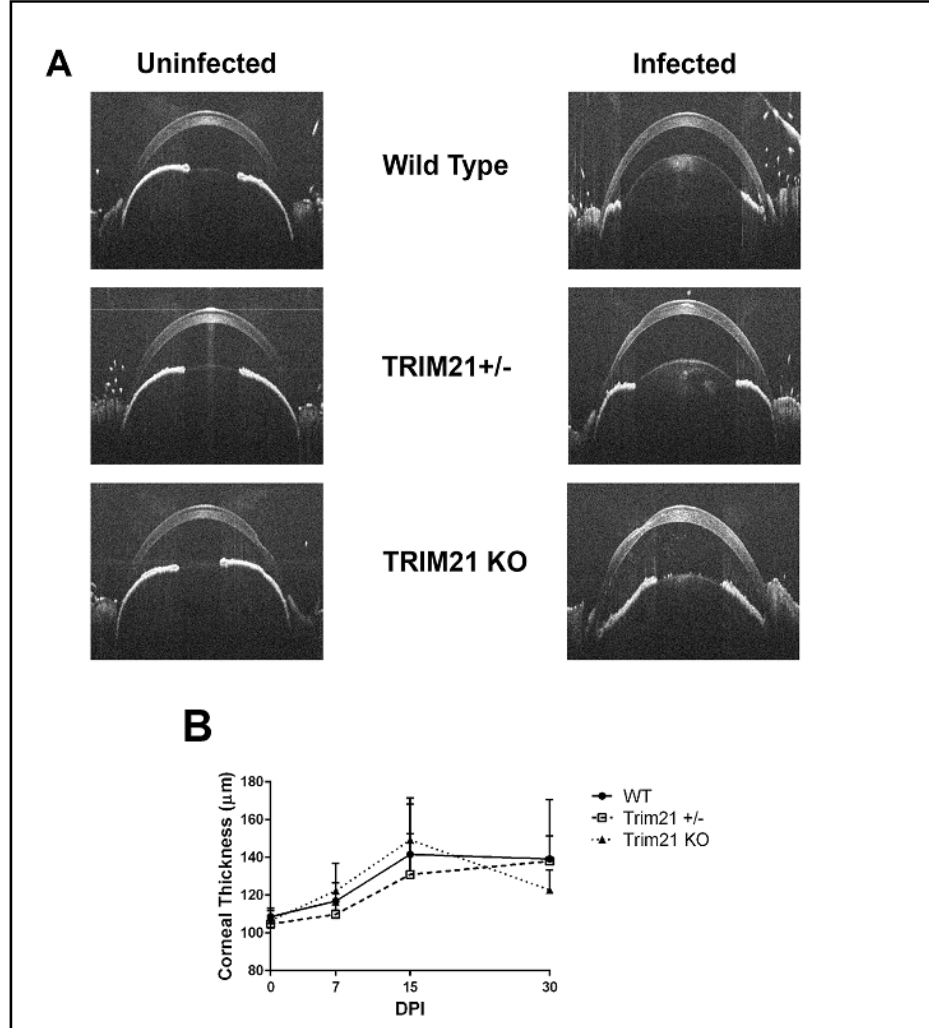
Figure 5. Cornea edema is similar between WT, TRIM21+/ − , and TRIM21 KO mice in response to HSV-1 infection. Male and female C57BL/6 (WT), TRIM21+/ − , and TRIM21 KO mice (n = 10–16/group/time point) were infected with HSV-1 (10 3 PFU/cornea). At the indicated time point before (0) or after infection, the mice were sedated and the corneas were measured for thickness by spectral-domain optical coherence tomography. ( A ) Representative figures for each mouse genotype prior to (uninfected) and at day 15 post infection (infected). ( B ) Summary of corneal thickness for each mouse genotype at each time point, taken prior to and after infection. The points represent the mean + SD.